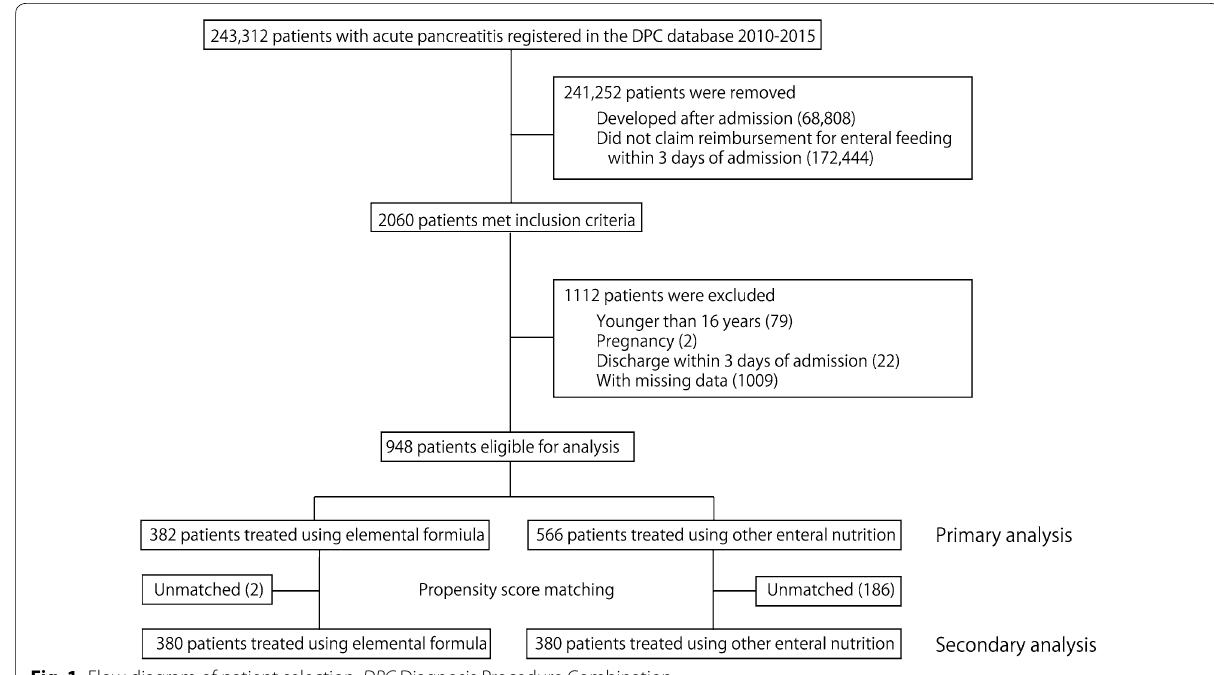
Fig. 1 Flow diagram of patient selection. DPC Diagnosis Procedure Combination